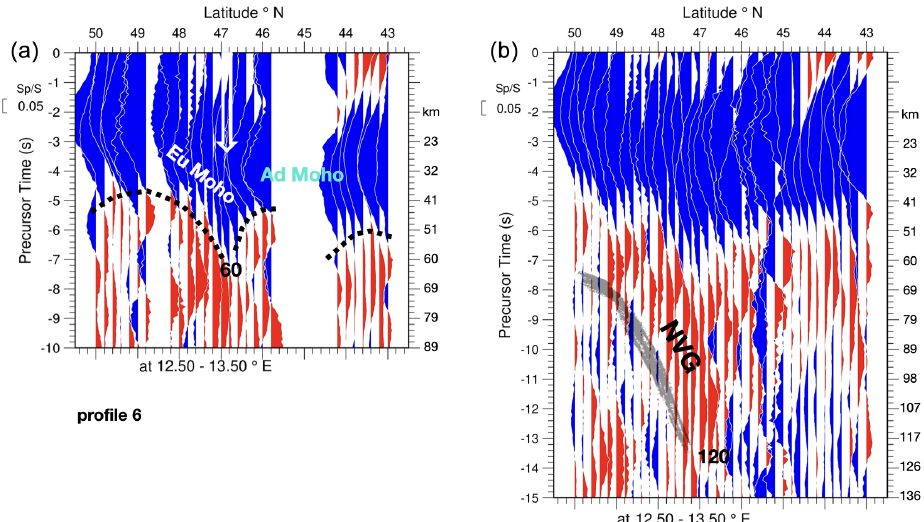
Figure 8. Profile 6. North–south profiles at 12.5–13.5 ◦ E, i.e. across the eastern part of the Tauern Window. Note that the deepest point of the Moho near 47 ◦ latitude, marked with a white arrow, closely coincides with the Europe–Adria boundary according to Spada et al. (2013) (see Fig. 2). This profile corridor does not reach the Ligurian Moho in the